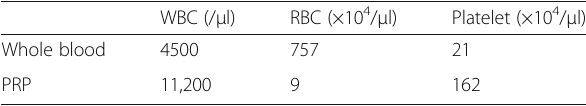
Table 1 WBC, RBC, and platelet counts in whole blood and PRP